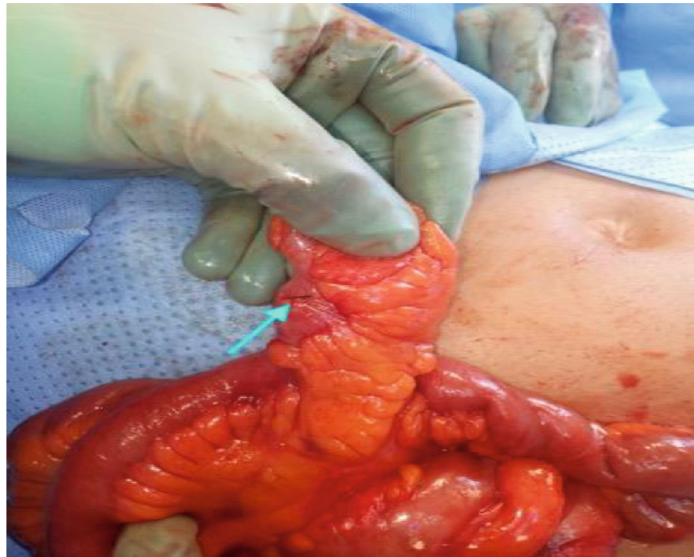
Figure 6: Meckel ’ s diverticulum containing the fi sh bone penetrating it in case 6.